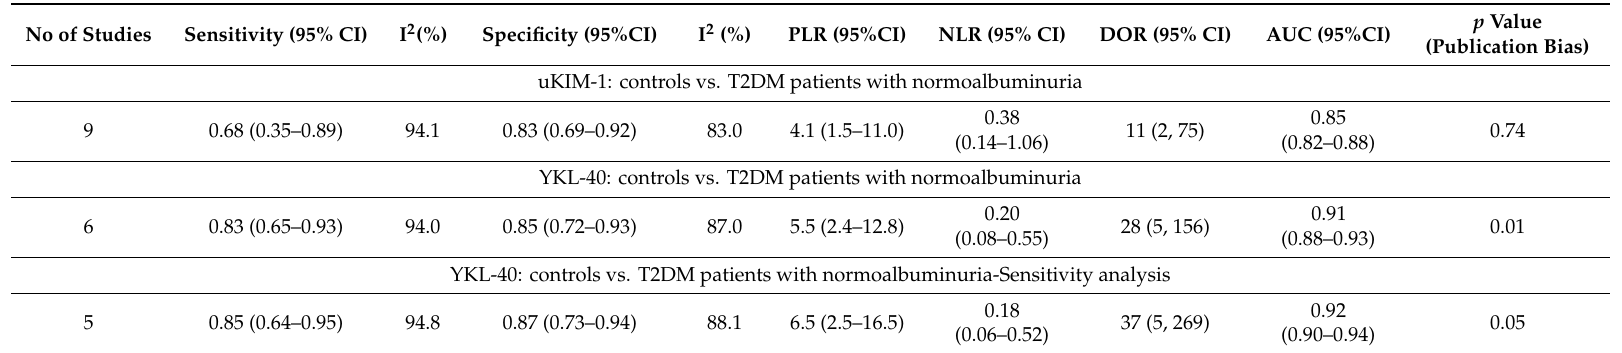
Table 4. Pooled diagnostic and prognostic accuracy of uKIM-1 and YKL-40 for the diagnosis of early DN in T2DM patients. Results of sensitivity analysis, p value of publication bias, and I 2 for heterogeneity are also